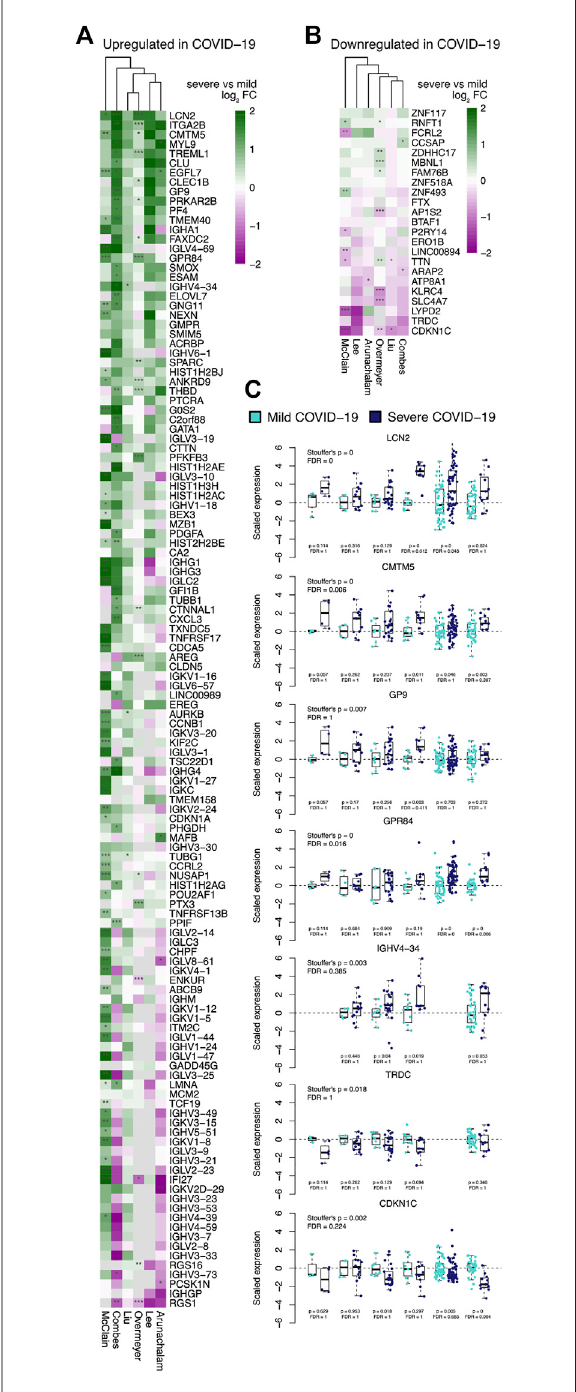
FIGURE 2 Association of the COVID-19 speci fi c signature genes with disease severity heatmaps showing logarithmic fold changes between the severe and mild cases across the different datasets separately for (A) upregulated and (B) downregulated COVID-19 speci fi c genes. The signi fi cance of Wilcoxon rank-sum test is indicated with asterisks in the heatmaps: * p < 0.05, ** p < 0.01, and *** p < 0.001. (C) Representative examples of genes with consistently higher or lower expression in the severe disease, with